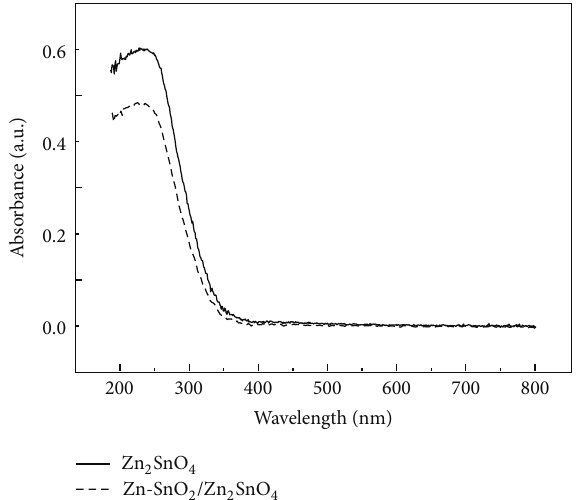
Figure 4: UV-vis absorbance spectra of pure Zn 2 SnO 4 and Zn- doped SnO 2 /Zn 2 SnO 4 nanocomposites.